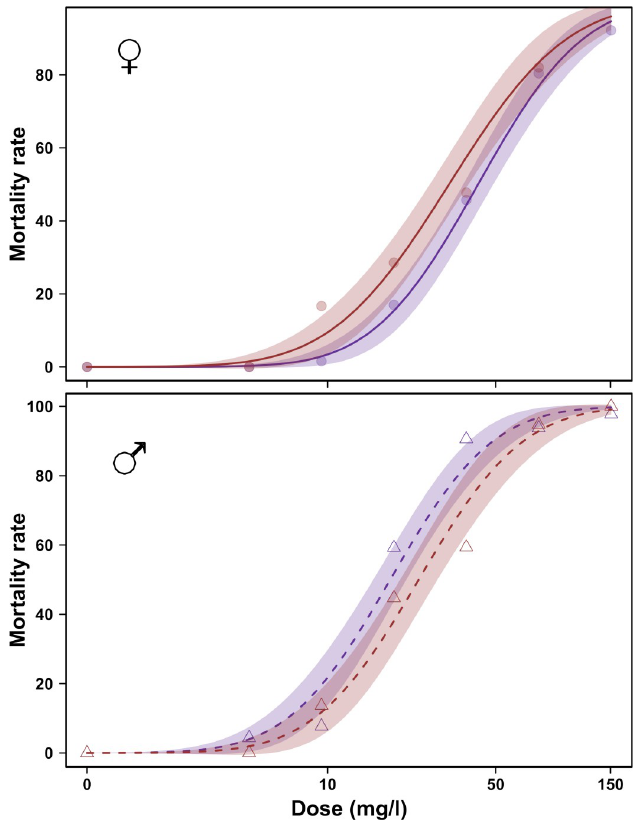
Fig 4. Effect of population genetic diversity on LD 50 in D . suzukii . Dose-response curves of D . suzukii 24 to 48 hour- old adults of the population Ste-Foy (blue) and the inbred SF-IsoA (red) derived from it, after 24 h of tarsal exposure to phosmet in females (top panel) and males (bottom panel). The 95% confidence intervals were derived from the dose- response model.